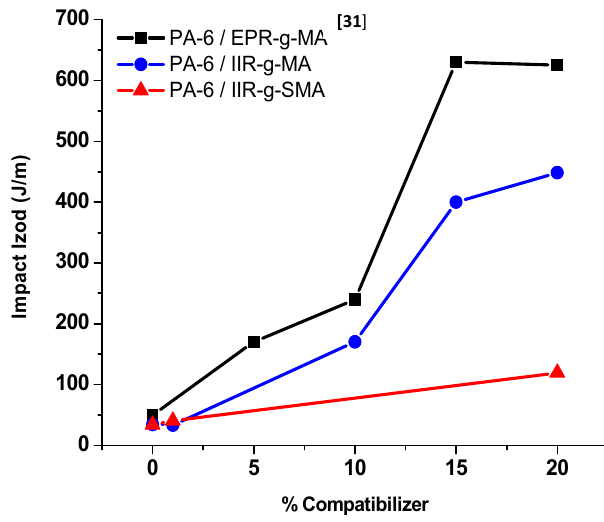
Figure 4. Comparison of the Izod impact strength of binary blends of IIR- g -MA and IIR- g -SMA with PA-6 as a function of total rubber content. A comparison is also made with data previously published for binary blends of PA-6 with ethylene-propylene rubber grafted with MA (EPR- g -MA) as modifier [31] .